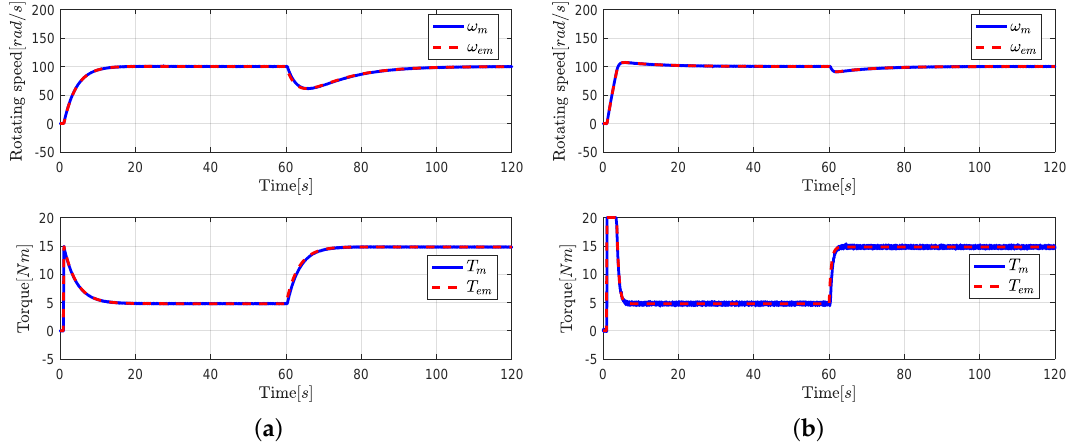
Figure 9. The responses of the motor torque T m with the conventional PI-type speed controller (21): J em = 20 J and B em = 40 B . ( a ) The experimental results (solid) and the desired response (dashed), K ps = 0.15 and K is = 0.015. ( b ) The experimental results (solid) and the desired response (dashed), K ps = 0.9 and K is =